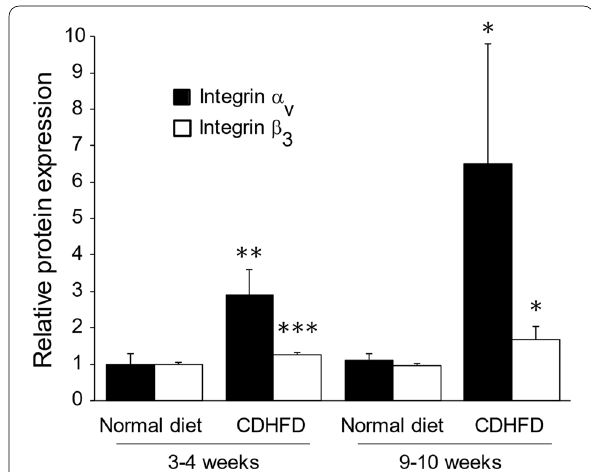
Fig. 3 Hepatic integrin α v and β 3 protein expression. Values are protein expression relative to that of the mean value for the 3–4-week normal-diet-fed group; means SDs ( n 5). The vertical axis values ± = are the integrin α v or β 3 protein expression relative to that of the mean of the 3–4-week normal diet-fed group. * P < 0.05; ** P < 0.01; *** P < 0.001 compared with the equivalent normal diet-fed groups. CDHFD choline-deficient, low-methionine high-fat